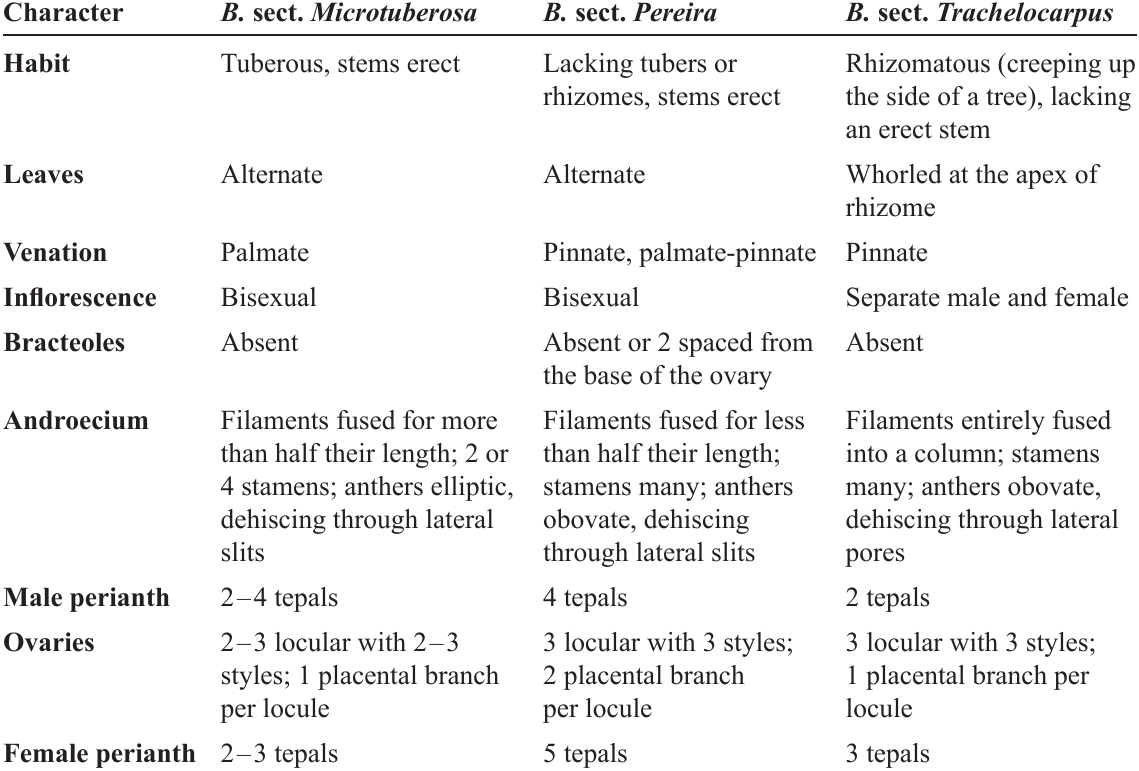
Table 1. Comparison between Begonia sect. Microtuberosa Moonlight & Tebbitt sect. nov. and closely related